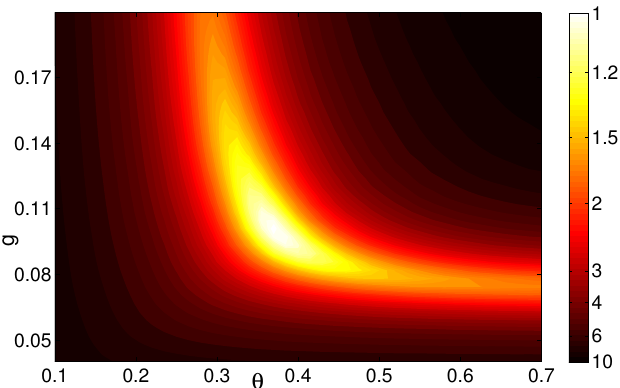
Figure 8: Relative fit error of the experimental data of Ref. [ 11 ] with regards to the theoret- ical description parameterized by the relative interaction strengths θ and g . The fit error is normalized with respect to the error found for the optimal fit parameters θ = 0.37 ± 0.03 and g = 0.101 ±